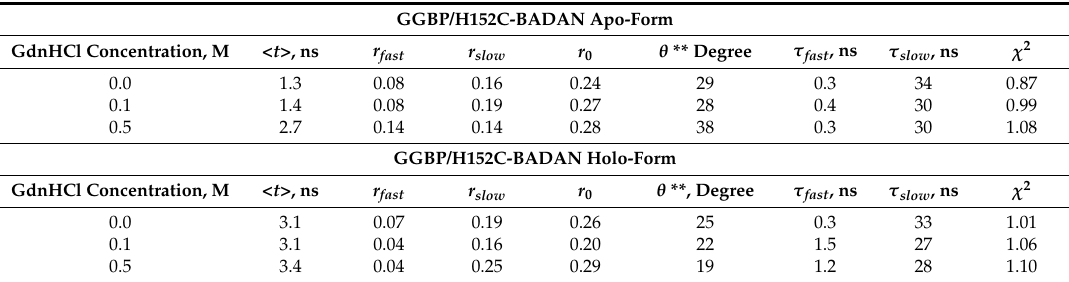
Table 1. The time-resolved characteristics of anisotropy fluorescence of BADAN linked to the GGBP/H152C in solutions with the sub-denaturing GdnHCl concentrations *. GGBP/H152C-BADAN Apo-Form GdnHCl Concentration, M < t >, ns r fast r slow r 0 θ ** Degree τ fast , ns τ slow , ns χ 2 0.0 GGBP/H152C-BADAN Holo-Form GdnHCl Concentration, M < t >, ns r fast r